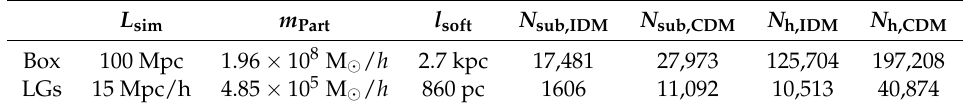
Table 1. Most relevant parameters of Box and Local Groups ( LGs ) simulations, together with their corresponding halo and subhalo abundances. Columns 2–4 indicate the box size L sim , the particle mass m Part , and the comoving softening length l soft . The rest of columns provide the total number of subhalos N sub,IDM/CDM and halos N h,IDM/CDM for each cosmological model. We remind that there are 4 LGs in each